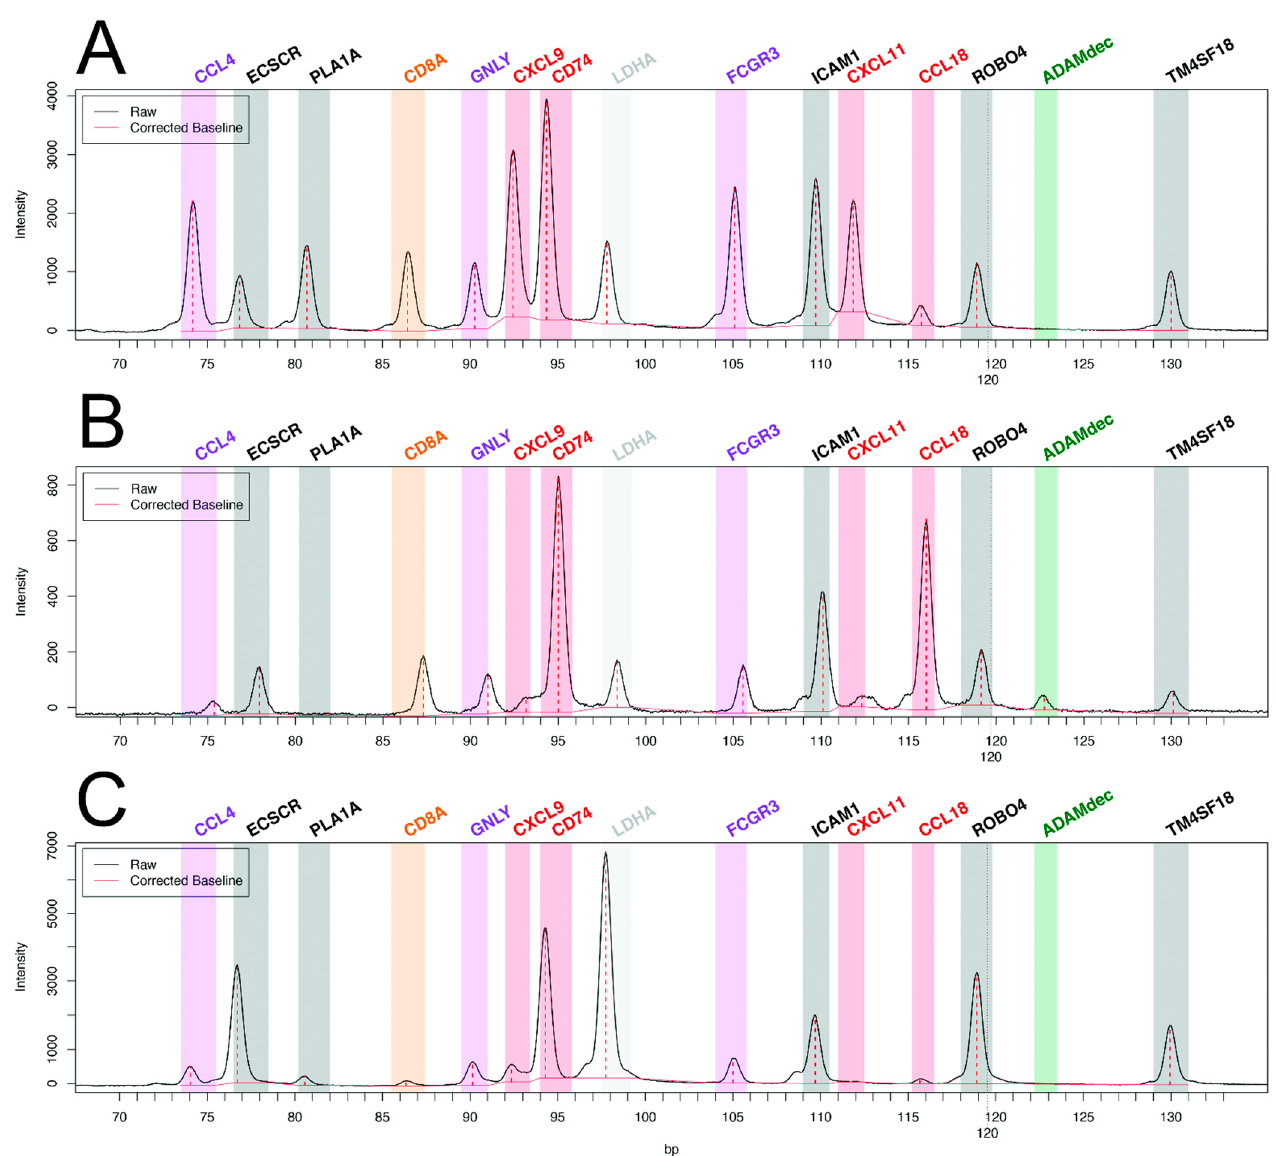
Figure 1. Molecular profiles of antibody-mediated rejection ( A ) with high expression of CCL4, PLA1A, GNLY, CXCL9, FCGR3, and CXCL11, and of acute cellular rejection ( B ) with high expression of ADAMdec and CCL18 as compared with non-rejecting control endomyocardial biopsy ( C ). Adapted from Adam et al. [63].